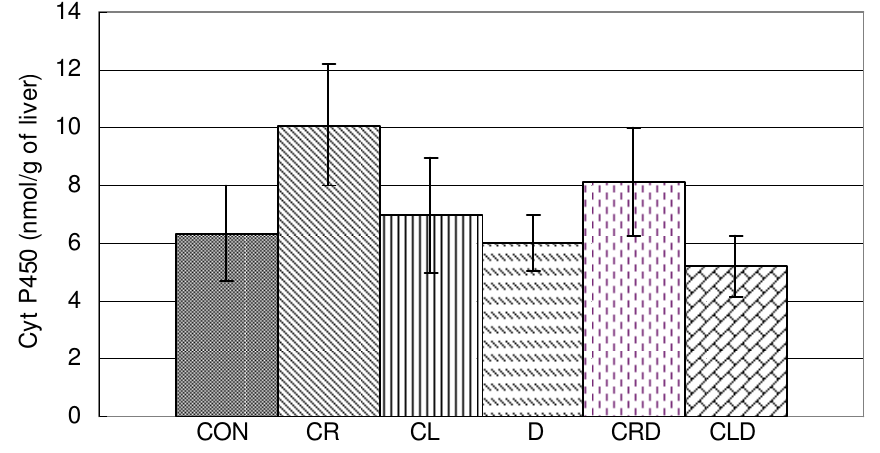
Figure 8. Effects of doxorubicin, celery leaves and roots juices and their combination on Cyt P450 in liver homogenate. t-test, n = 6; compared to CON group: * p < 0.05, compared to D group: a p <